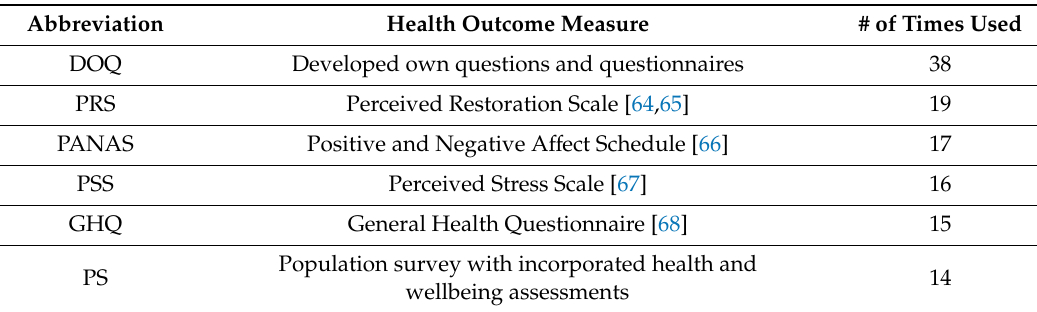
Table 7. An overview of the tools used to measure mental HWB and the number of times each tool has been used (where the available primary reference for each tool is added in